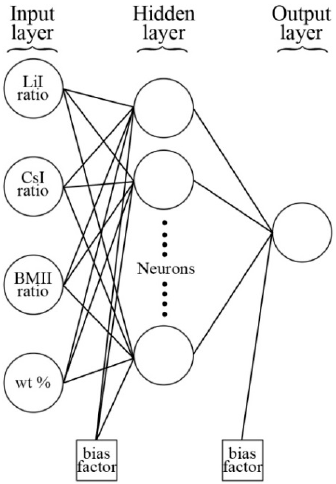
Figure 10. General scheme of the artificial neural network.